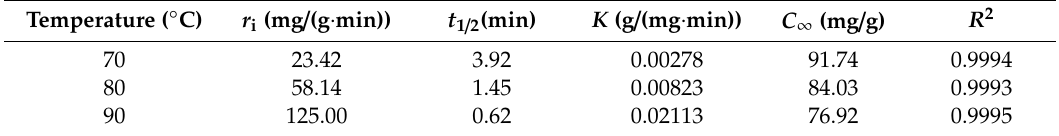
Table 1. Kinetic parameters of tannic acid obtained from the pseudo-second-order model.